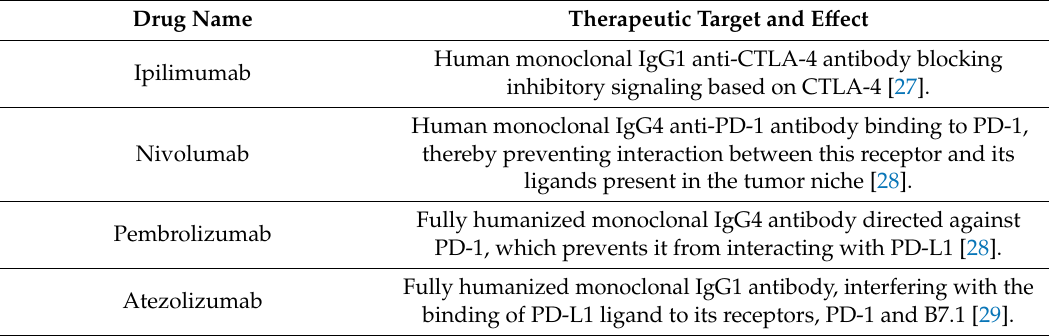
Table 2. Immune checkpoint inhibitors used in melanoma